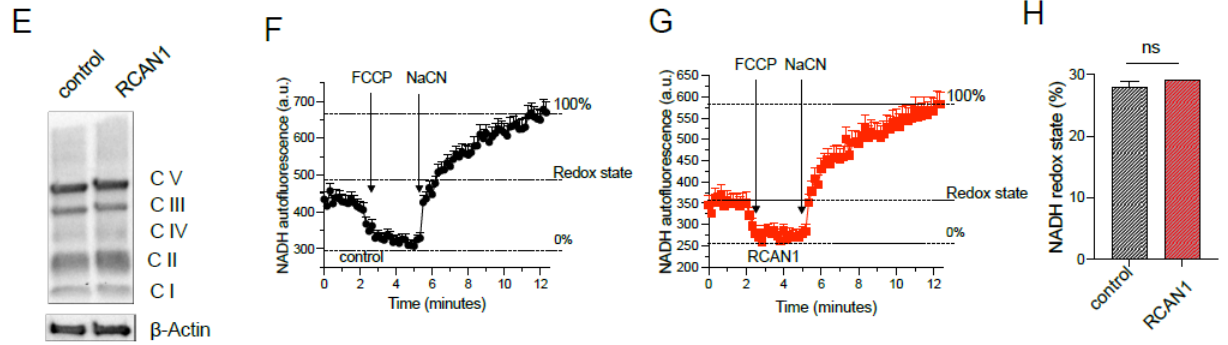
Figure 3. ( A ) Quantification of the reduced (GSH) to oxidized (GSSG) glutathione in LS8 overex- pressing Rcan1. ( B ) Traces of MitoSOX measurements in control and Rcan1 overexpressing LS8 cells. ( C ) Oxygen consumption rate (OCR) measured in control and RCAN1 overexpressing LS8 cells. ( D ) Quantification of basal respiration, spare respiratory capacity, proton leak, and ATP-linked mitochondrial respiration. ( E ) Western blot showing the expression of the mitochondrial complex proteins I–IV and the ATP synthase in control and RCAN1 overexpressing LS8 cells. ( F – H ) NADH autofluorescence in control ( F ) and RCAN1 overexpressing ( G ) LS8 cells. ( H ) Quantification of the redox state. Data represent the mean ± SEM of three independent experiments analyzed by Student’s t -test. * p < 0.05, ** p < 0.01, **** p < 0.0001.